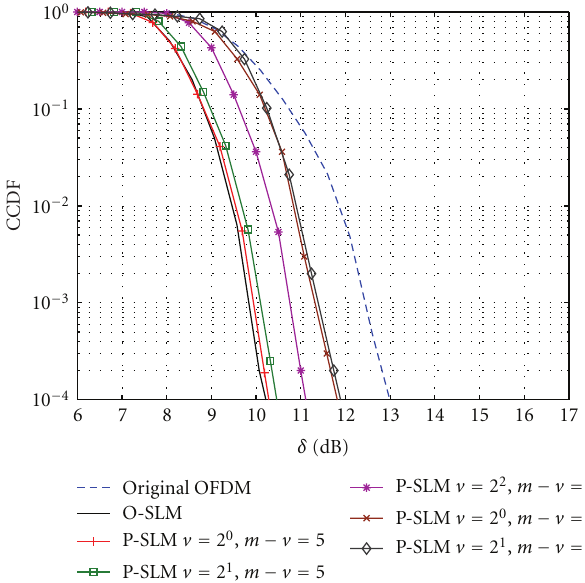
p 2 and 3 . Figure 17: PAPR CCDF for O-SLM and partial SLM for various numbers of remaining stages m − v and subsets, ν , and 8 SLM sequences with r = 2 and N =